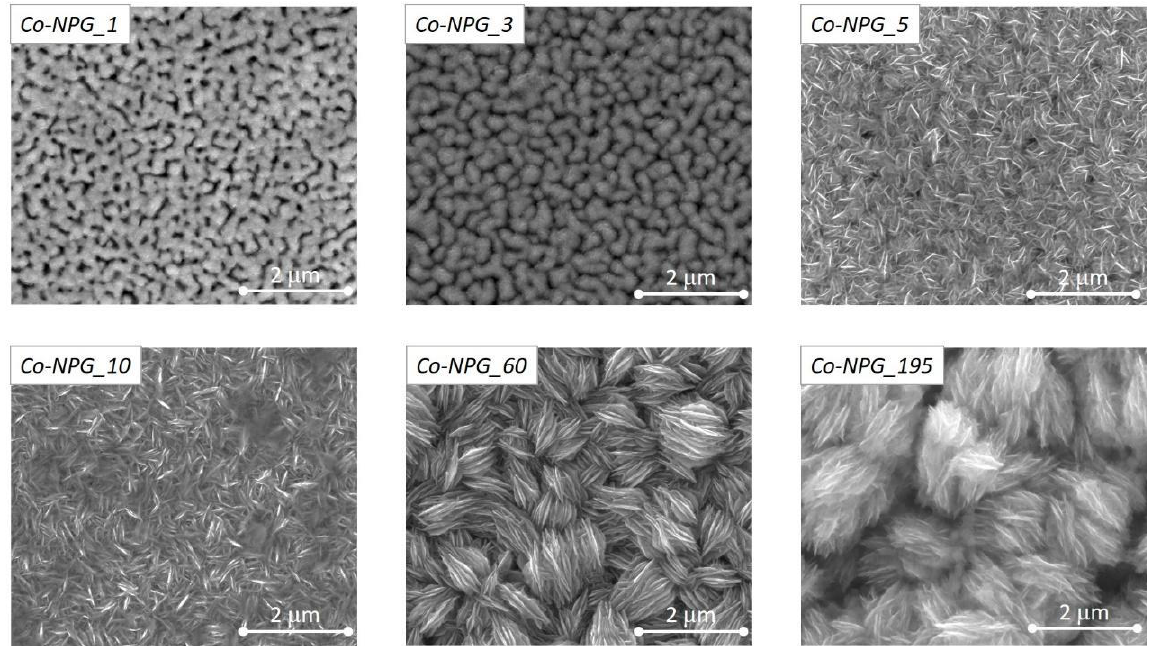
Figure 3. SE-SEM top-view image of the morphology of all studied hybrid Co/NPG heterostructures.